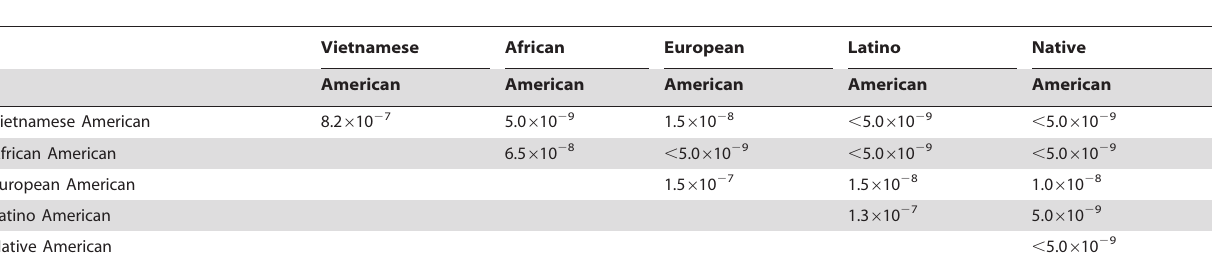
Table 1. False positive parent-offspring identification rates between pairs of unrelated individuals simulated from all pairs of population